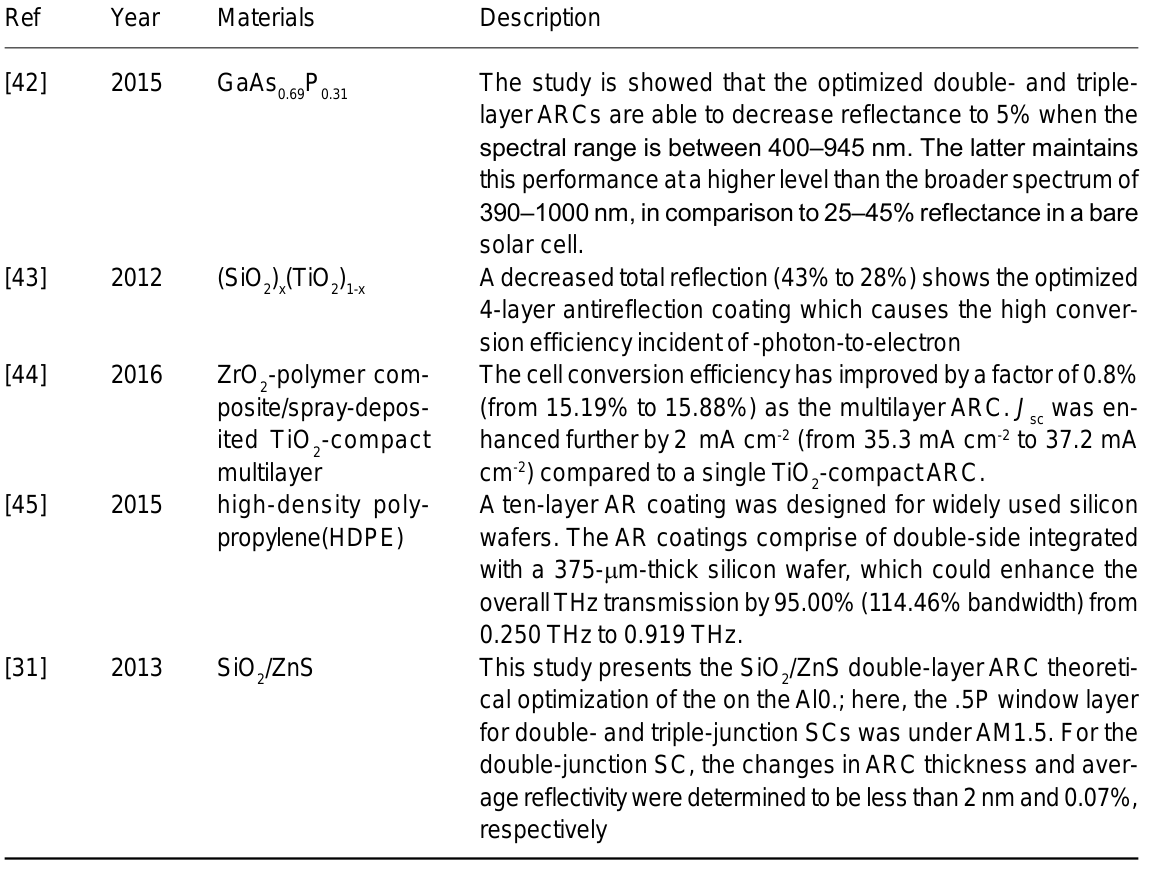
Table 2. A summary of multilayer ARCs achievements.